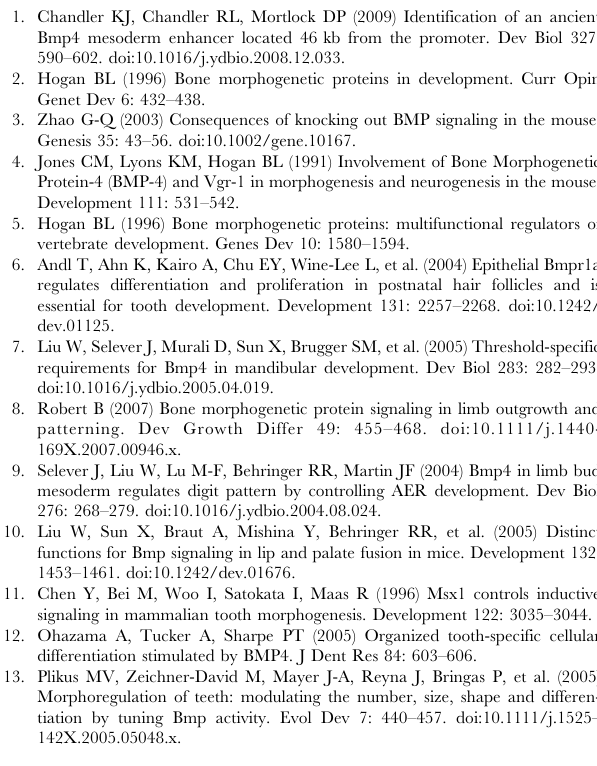
Figure S4 Pitx and Msx binding sites in the Bmp4 IE/LB